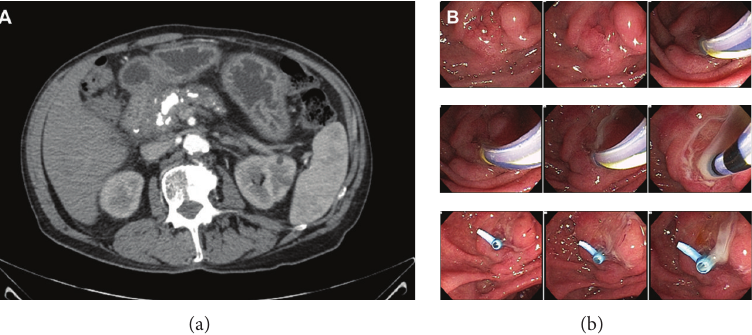
Figure 1: (a) CT scan prior to ERCP, illustrating evidence of chronic pancreatitis and pancreatic duct stricture, without associated pseudocyst, abscess, or necrosis and (b) ERCP demonstrating frank purulent drainage at the pancreatic duct.